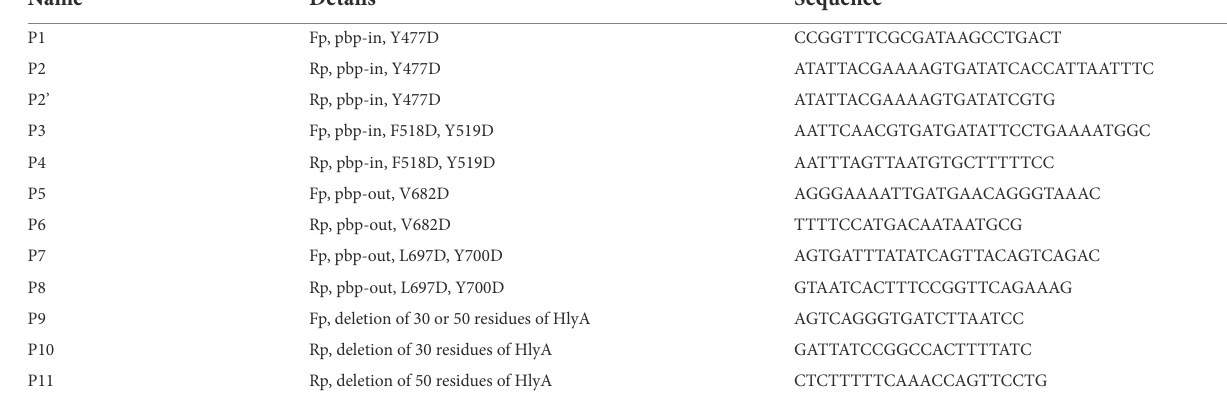
TABLE 2 Oligonucleotides used in this